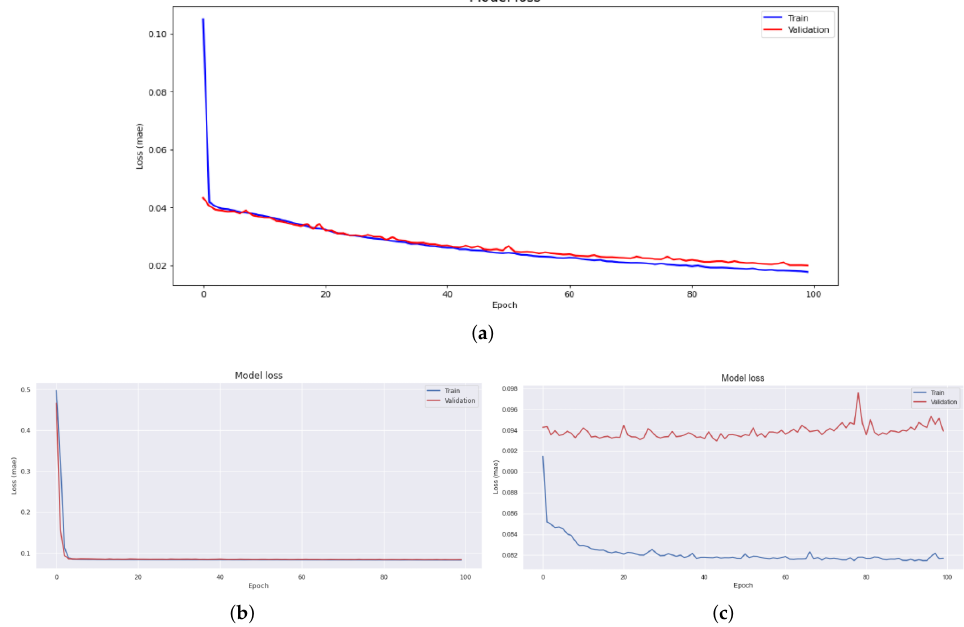
Figure 15. The results of using the reconstrued data by SSA, the loss graph ( a ) result of using the convolutional auto-encoder, ( b ) result of using the auto-encoder LSTM, and ( c ) result of using the